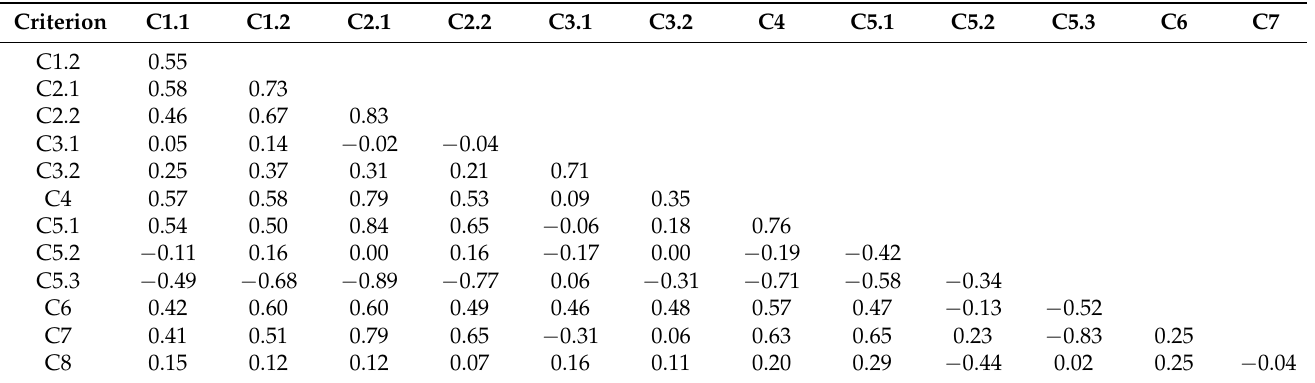
Table 7. Correlation on criteria—Pareto-optimal 71,599 solutions. Criterion